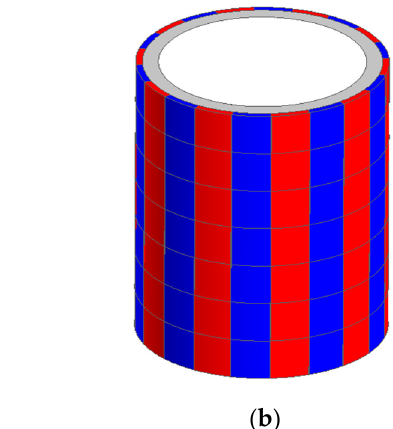
Figure 5. Stator ( a ) and rotor ( b ) of the designed prototype. Table 4. Main geometric parameters of the prototype drive .